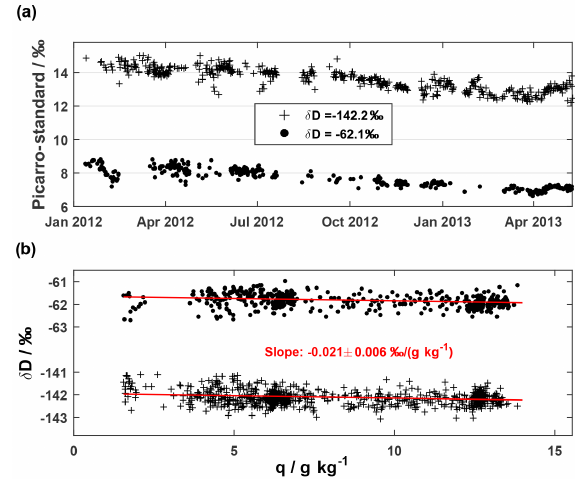
Figure 4. (a) Deviation of individual calibration measurements with the Picarro water isotopologue analyzer from isotope ratios of the liquid standards. Each point represents a calibration of 1h. Dots: Standard 1; crosses: Standard 2. (b) Humidity dependence of the δ D measurements. Long-term drift depicted in (a) was removed in (b) by subtracting the 5-week running average of calibrations. Red re- gression lines were calculated for both standards simultaneously by subtracting the mean difference between both standards. ± gives the difference between the slopes calculated for the first and second half of the measurement